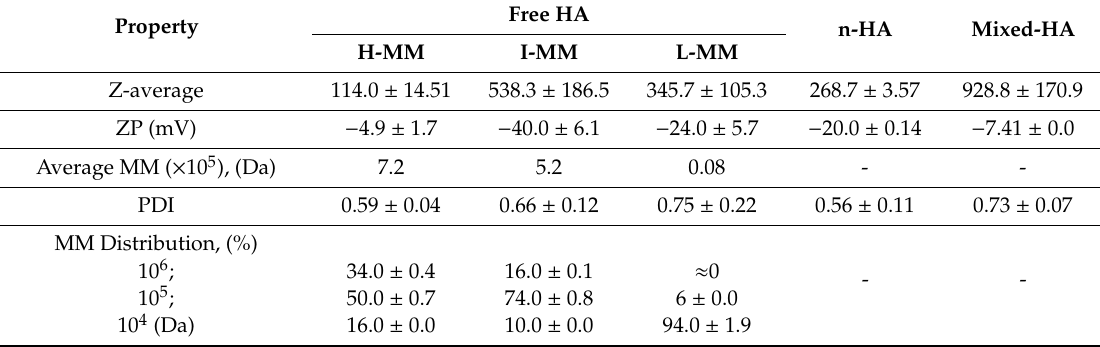
Table 1. Average hydrodynamic size (Z-average), zeta potential (ZP), average molar mass (MM), polydispersity index (PDI) and MM distribution: Free hyaluronic acids (HAs) (f-HA) with high (H-MM), intermediate (I-MM), and low (L-MM) molar mass (MM); the crosslinked HA nanoparticles (n-HA) and the mixed formulations (nanoparticles + IMM − HA) (mixed-HA) with 25% or 50% (wt.) of nanoparticles. All formulations were bu ff ered in pH 7.4 aqueous dispersions. (-) not determined. Free HA Property